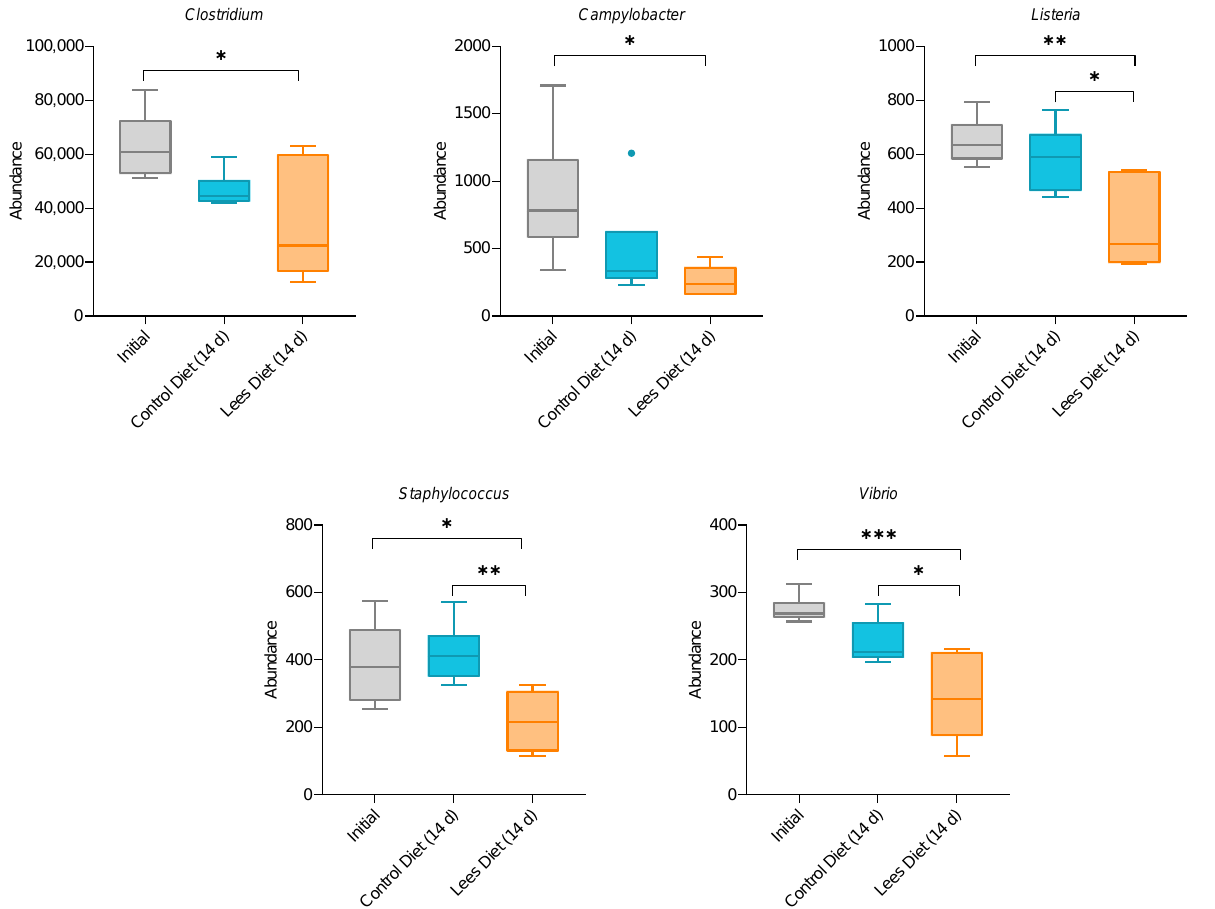
Figure 3. Difference between groups (control diet and lees diet) regarding the initial abundance of different genera of pathogenic bacteria. Significant differences between groups are indicated with asterisks